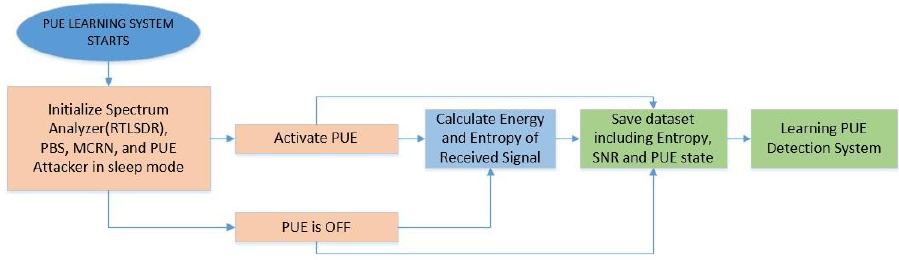
Figure 8. PUE learning system flowchart.